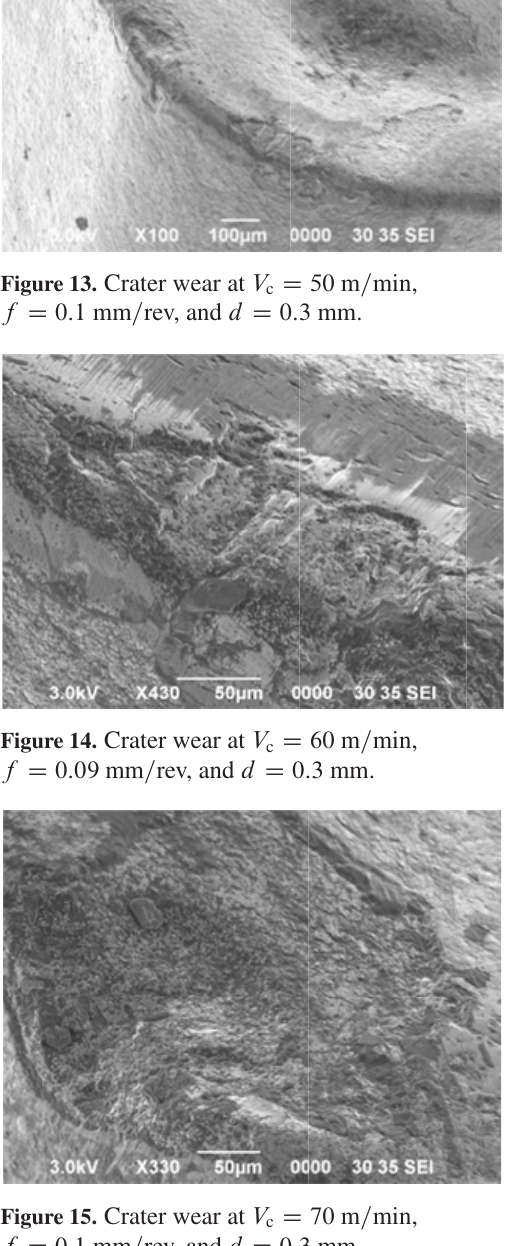
Figure 12. Crater wear at V c D 70 m = min, f D 0:1 mm = rev, and d D 0:5 mm.